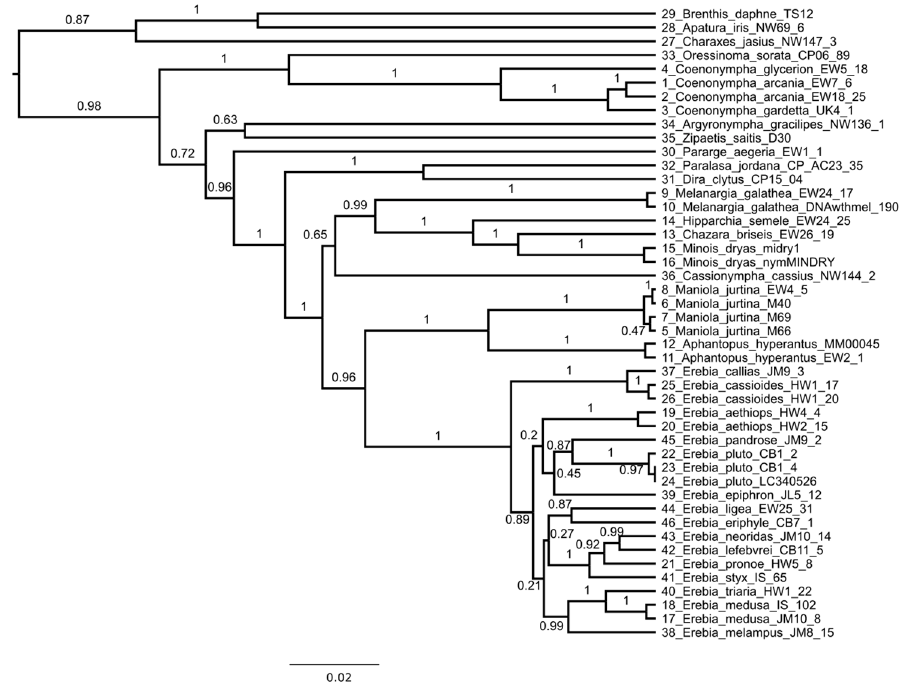
Figure A1. Bayesian tree (Beast) of Satyrinae butterflies. Branch labels show posterior probabilities.